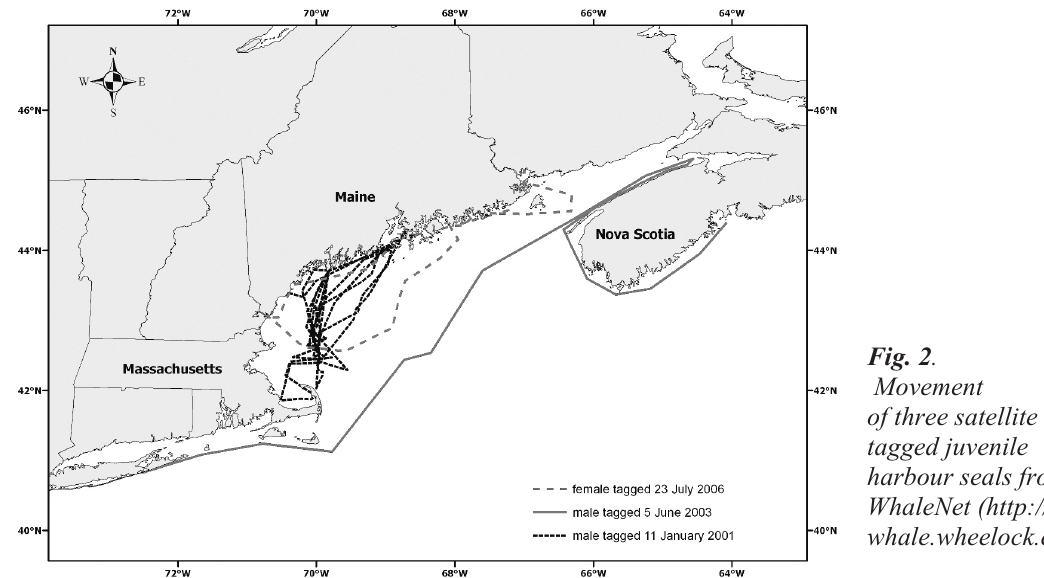
Fig. 2 . Movement of three satellite tagged juvenile harbour seals from WhaleNet (http://